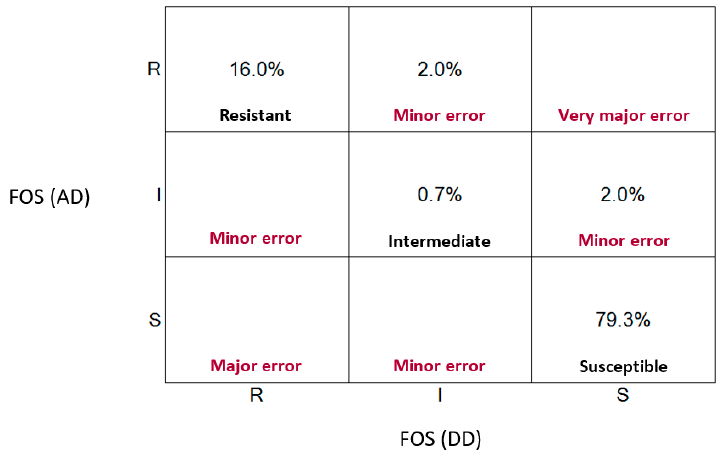
Figure 1. Scatter plot representing clinical errors between disk diffusion and agar technique.